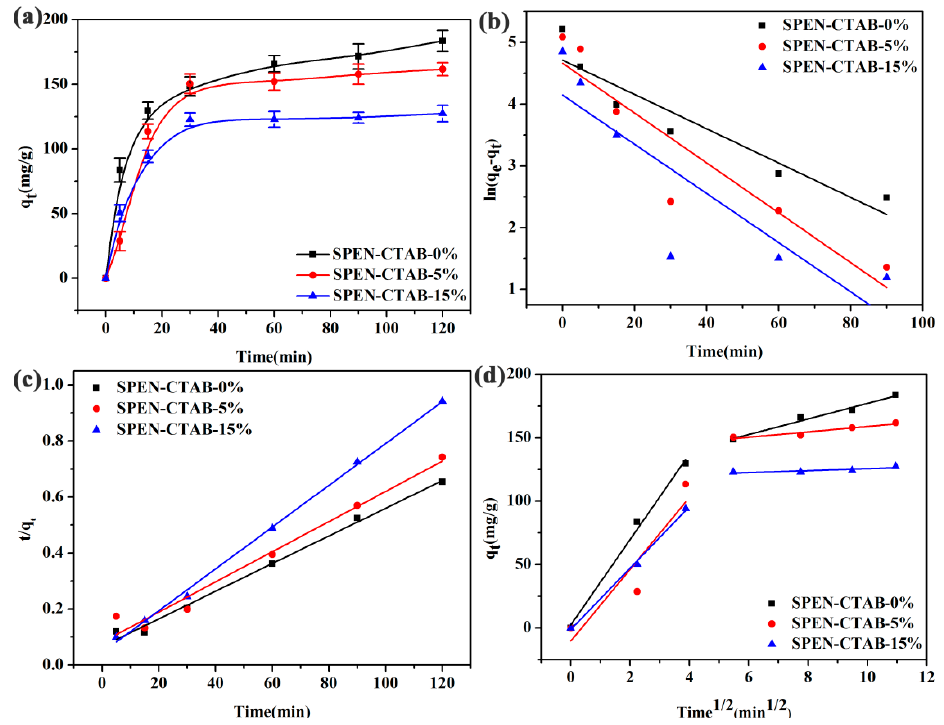
Figure 5. ( a ) Effect of contact time on Pb(II) adsorption capacity, ( b ) pseudo-first-order, ( c ) ( a ) E ff ect of contact time on Pb(II) adsorption capacity, ( b ) pseudo-first-order, pseudo-second-order, and ( d ) intraparticle diffusion kinetic models ( d ) for the adsorption of Pb(II) ( c ) pseudo-second-order, and ( d ) intraparticle di ff usion kinetic models ( d ) for the adsorption of onto SPEN-CTAB-0%, SPEN-CTAB-5% and SPEN-CTAB-15%, respectively. Pb(II) onto SPEN-CTAB-0%, SPEN-CTAB-5% and SPEN-CTAB-15%, Table 2. The kinetic parameters of adsorption of Pb(II) onto SPEN-CTAB-0%, SPEN-CTAB-5% and SPEN-CTAB-15%.